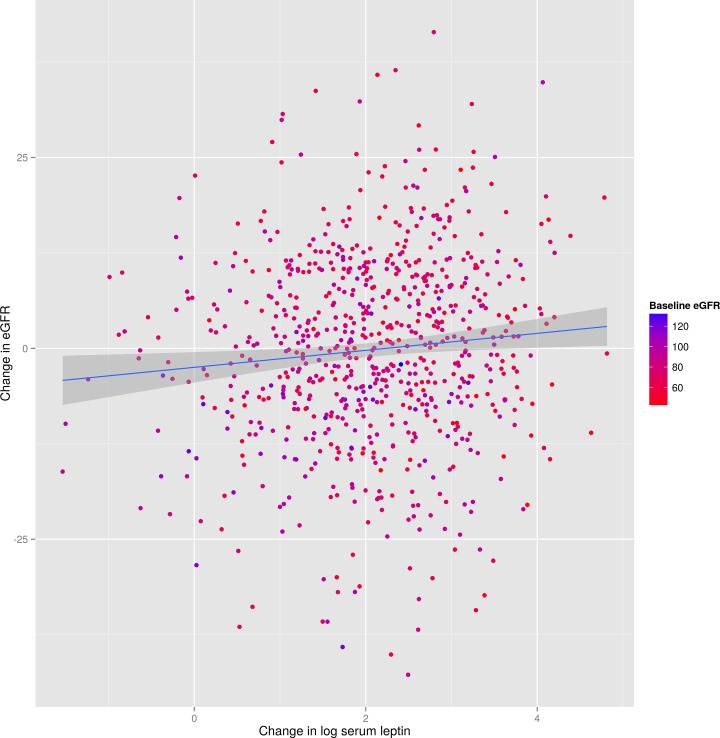
Relationship between changes in eGFR at 6 years and change in (log) leptin at 6 years.Colors indicate baseline eGFR values.